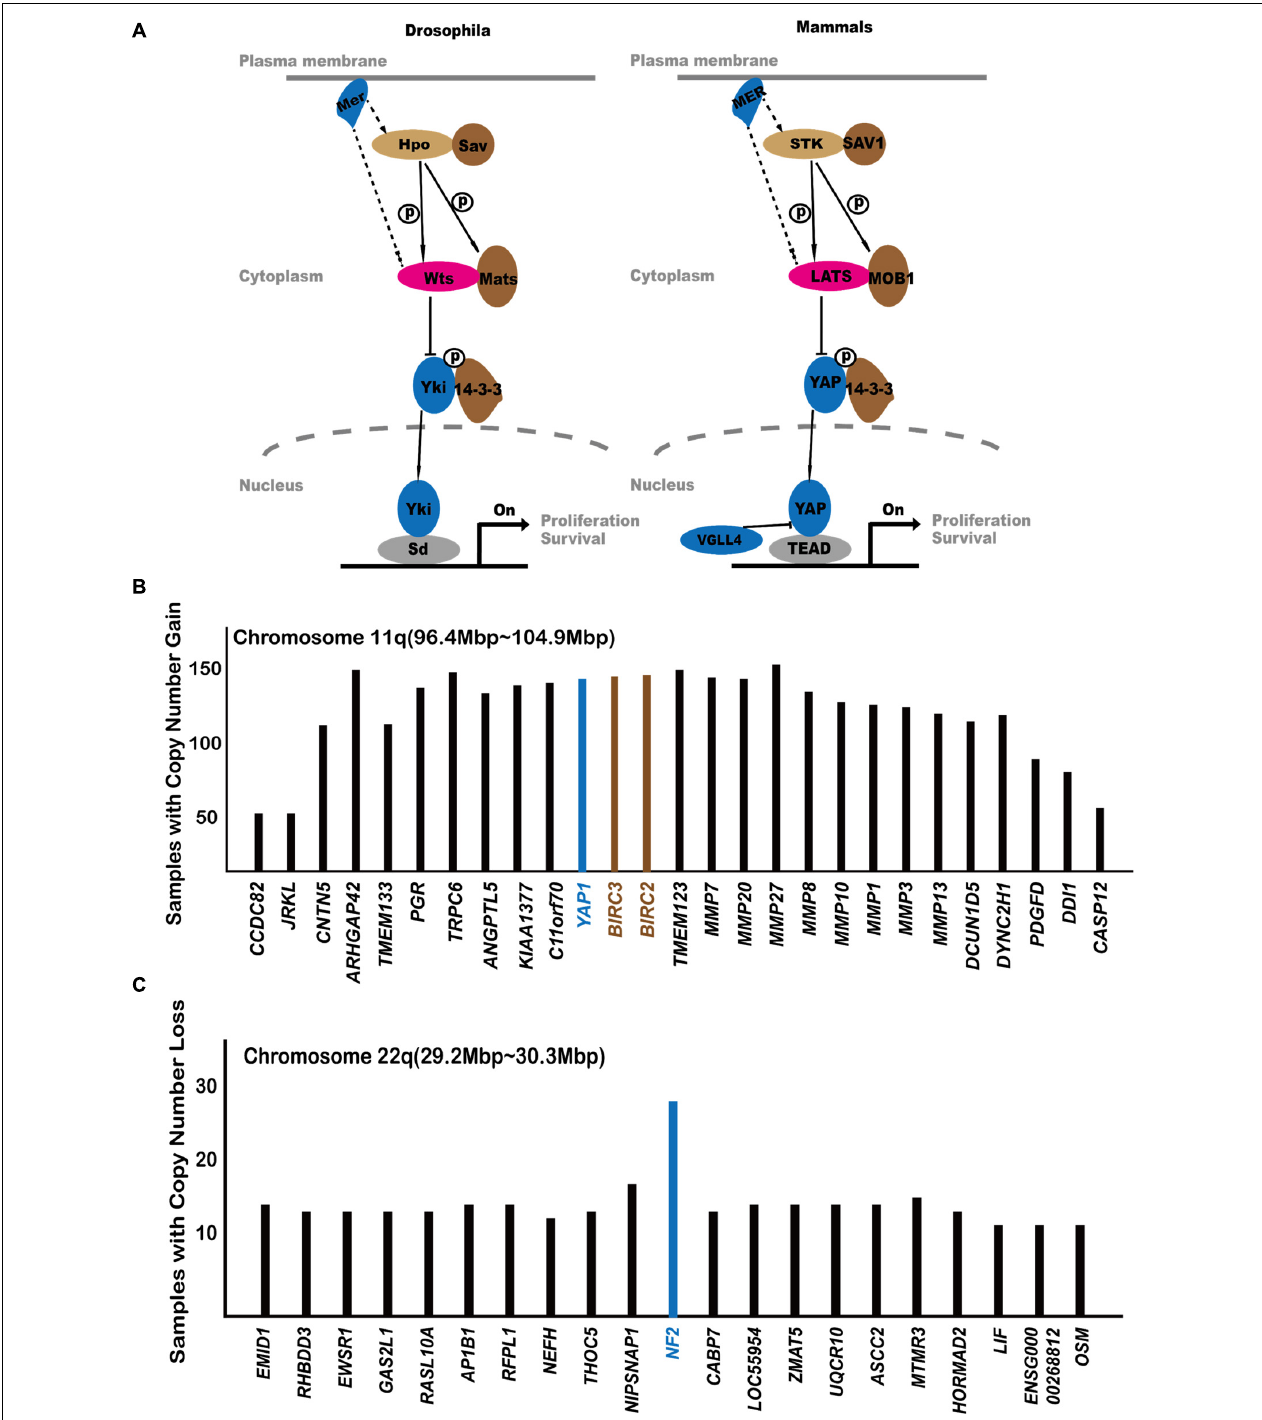
FIGURE 1 | The central players of the Hippo pathway. (A) The originally established core components of the Hippo pathway. (B) Analysis of COSMIC gene amplification data with regard to the 11q22 amplicon. Genes are arranged according to their locations on chromosome 11q22. The Y axis shows how many cancer samples in COSMIC database exhibit gene amplification of each gene. If a gene is located at the amplification peak position, it is more likely to be a cancer-driving event. (C) Analysis of COSMIC gene amplification data with regard to the 22q deleted region.